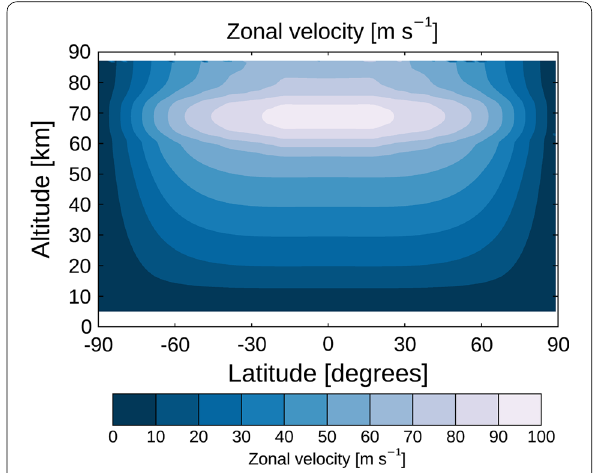
Fig. 1 Meridional distribution of the basic zonal velocity